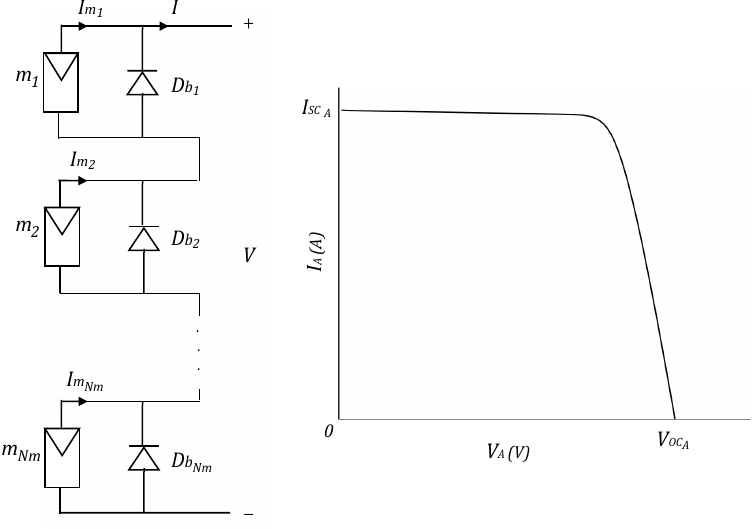
Figure 3. Left : Structure of a PV module formed by N m submodules operating under uniform conditions. Right : PV module I-V